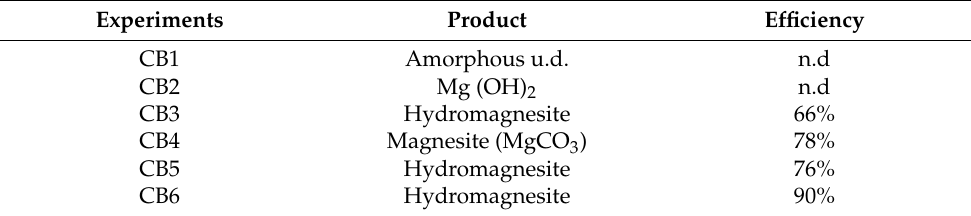
Table 7. Products of the mineral carbonation process.